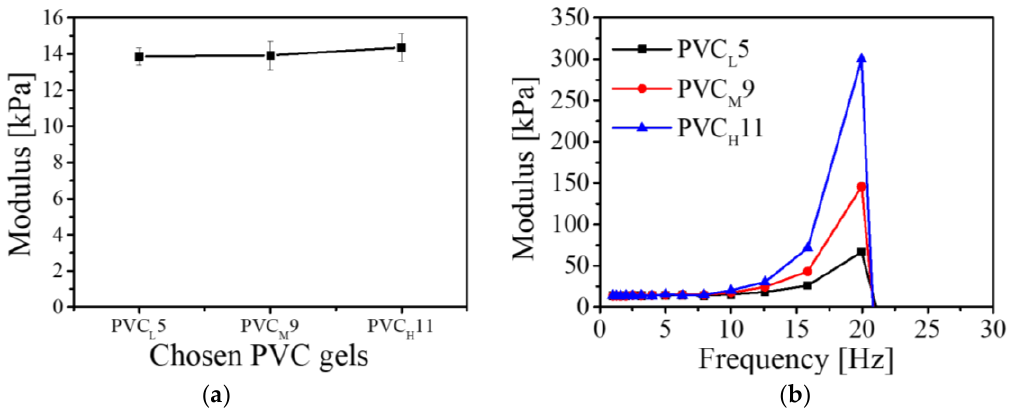
Figure 9. Dynamic mechanical analysis of PVCs with different molecular weight: ( a ) Dynamic mechanical analysis (DMA) results in the time domain; and ( b ) DMA results in the frequency domain.